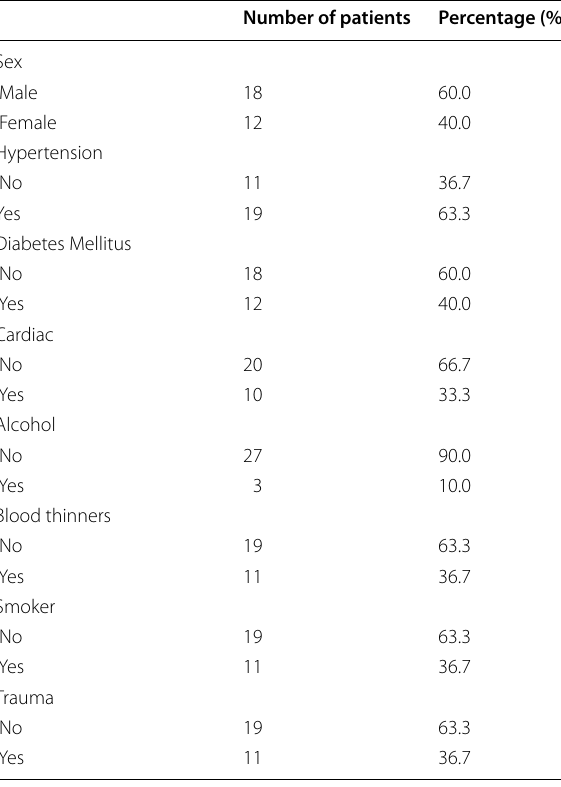
Table 1 Demographic data and risk factors of the studied patients